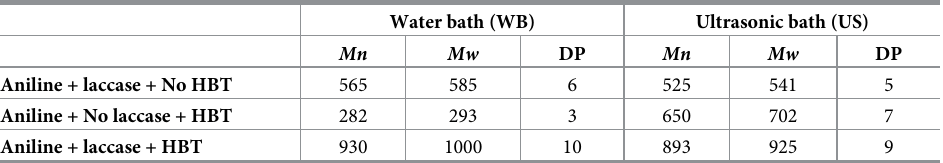
Table 1. Polyaniline characterization in terms of Mn , Mw and average polymerization degree (DP) using water bath and ultrasonic bath for reaction, evaluated by